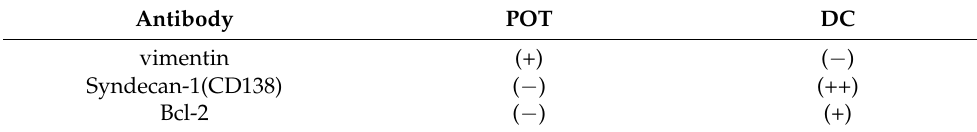
Table 2. Immunohistochemical findings of epithelium in this case and DC in previous reports [7,9,10]. Antibody